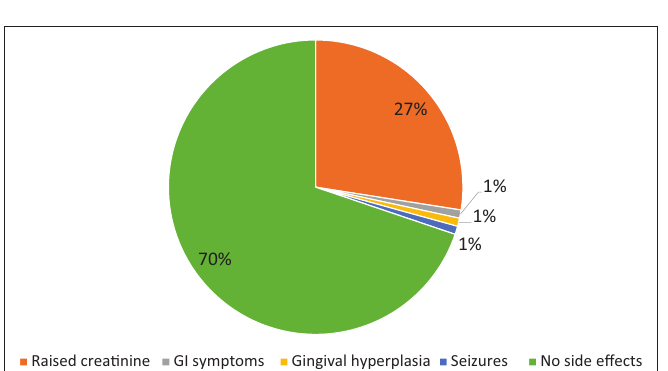
Figure 1. Safety profile of cyclosporine in all patients (n = 102).